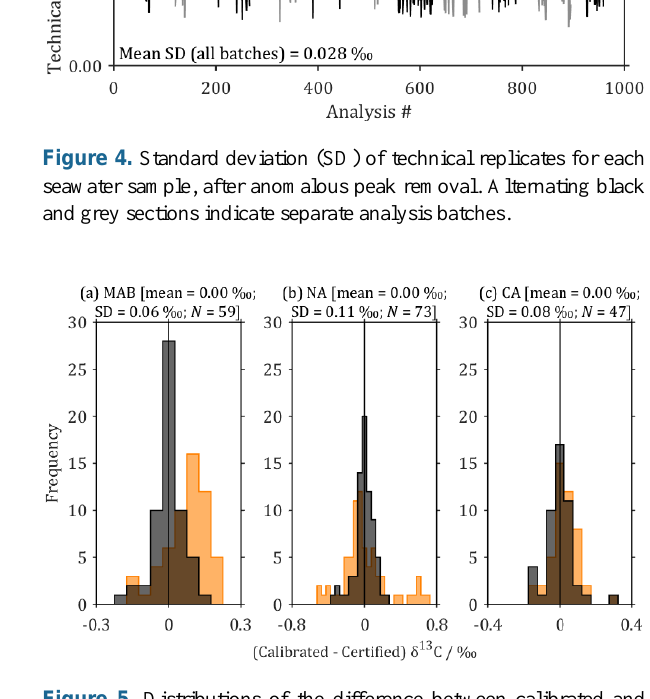
Figure 5. Distributions of the difference between calibrated and certified δ 13 C for calibration standards (a) MAB, (b) NA and (c) CA (Table 2) in all batches. The orange histograms indicate the dis- tributions resulting from using a linear calibration equation, while the overlying black-grey histograms show the improved distribu- tions from the non-linear calibration that we used instead (Eq. 4). SD: standard deviation; N : number of analyses, both in reference to the black-grey histograms, which represent the actual calibration